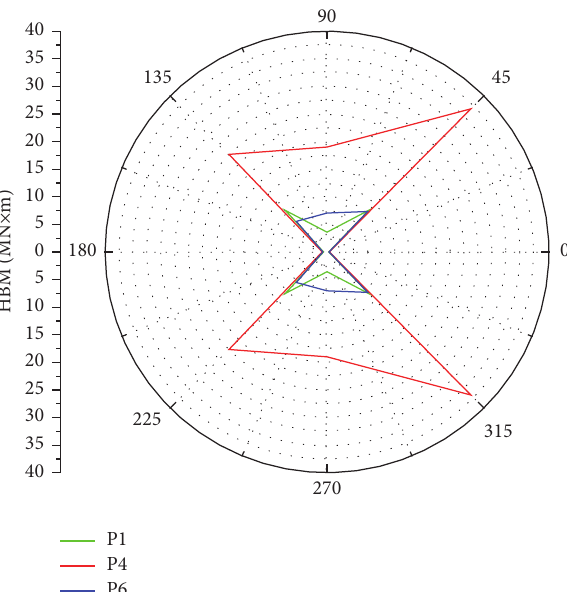
Figure 28: HBM of main hull in different azimuths.